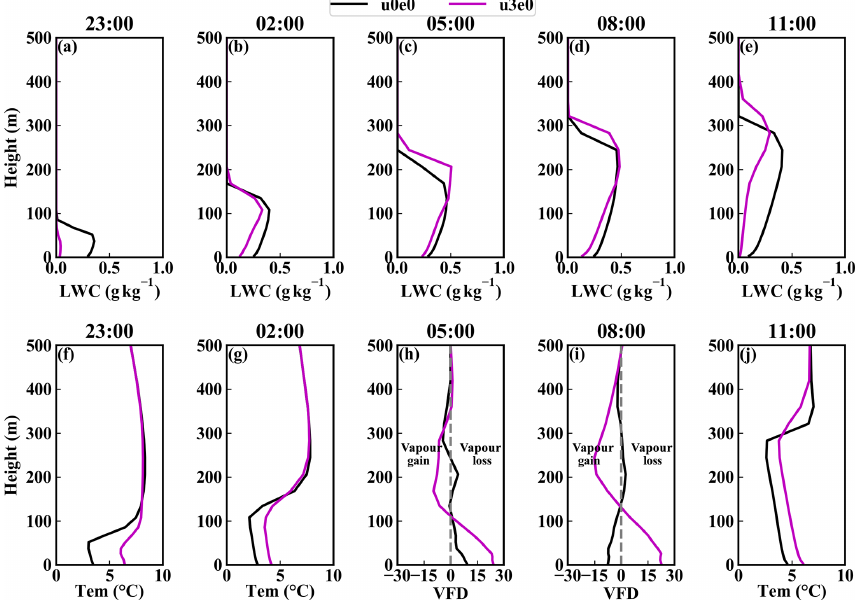
Figure 6. Profiles of the LWC (a–e) , temperature (Tem) (f, g, j) and vertical vapour flux divergence (VFD) (h, i) (gh − 1 m − 2 hPa − 1 ) in u0e0 and u3e0 at different